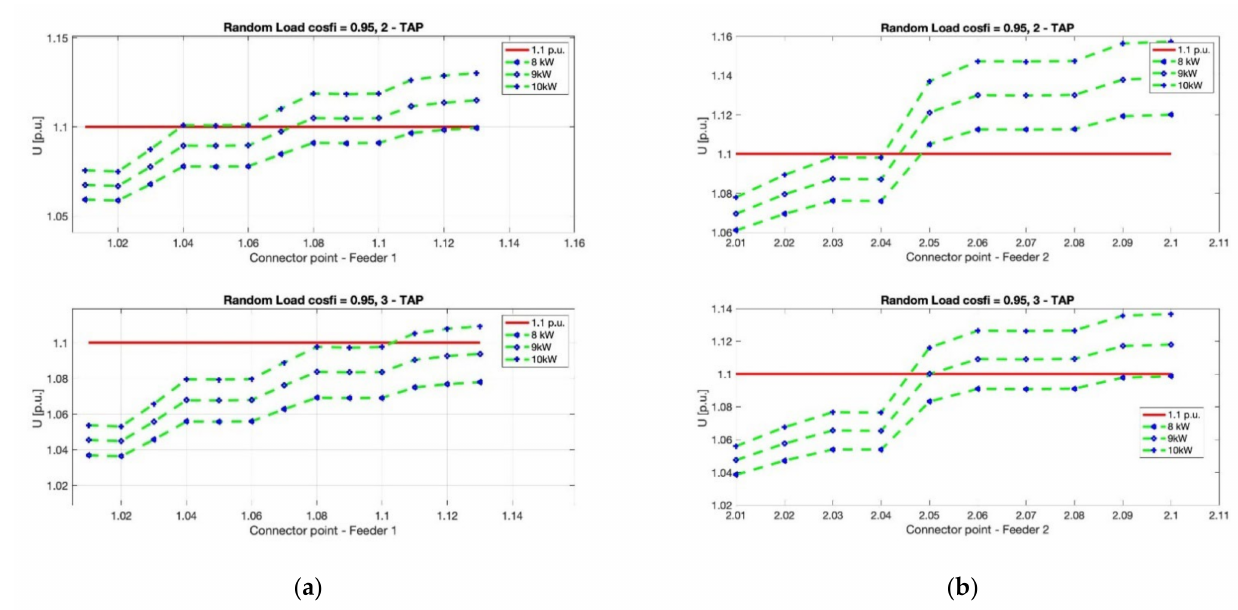
Figure 7. Scenario R, power factor = 0.95, TAP–2 and 3, Feeder 1–( a ) and Feeder 2–( b ).